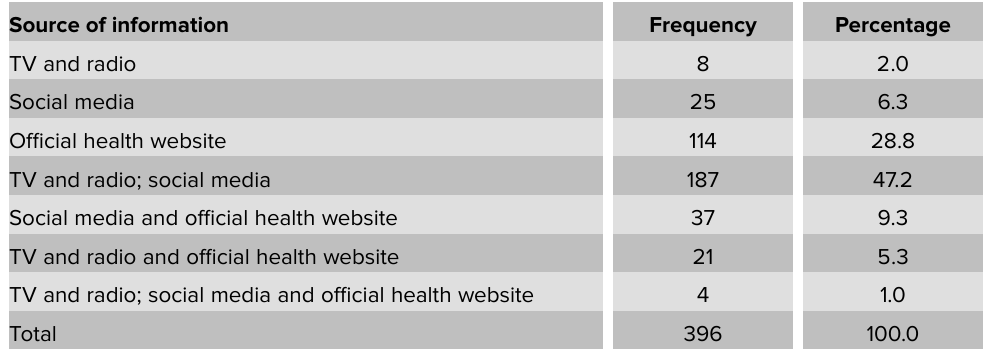
TABLE 4: Source of participants’ information about COVID